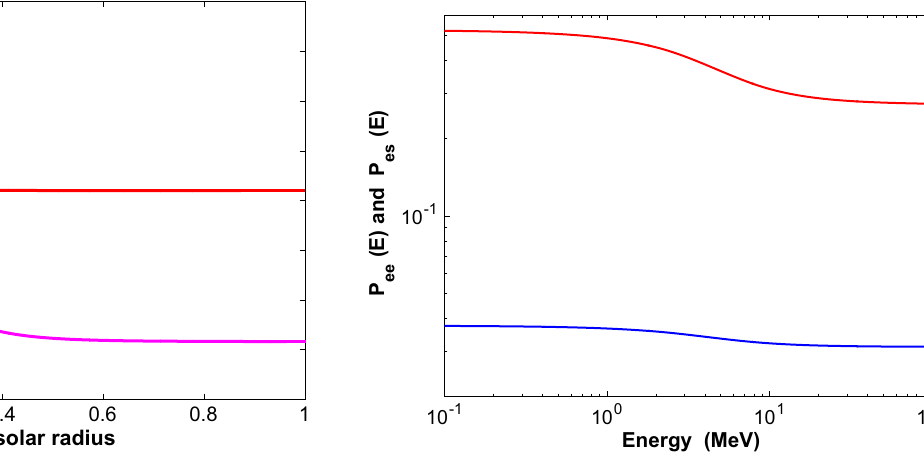
Fig. 2 Thelevelcrossingscheme:Themasseigenvalues λ 1 (redcurve) and λ 2 (magenta curve) as a function of the solar radius (cf. Eq. (1)). These λ values correspond to a neutrino with an energy E = 3 . 5 MeV